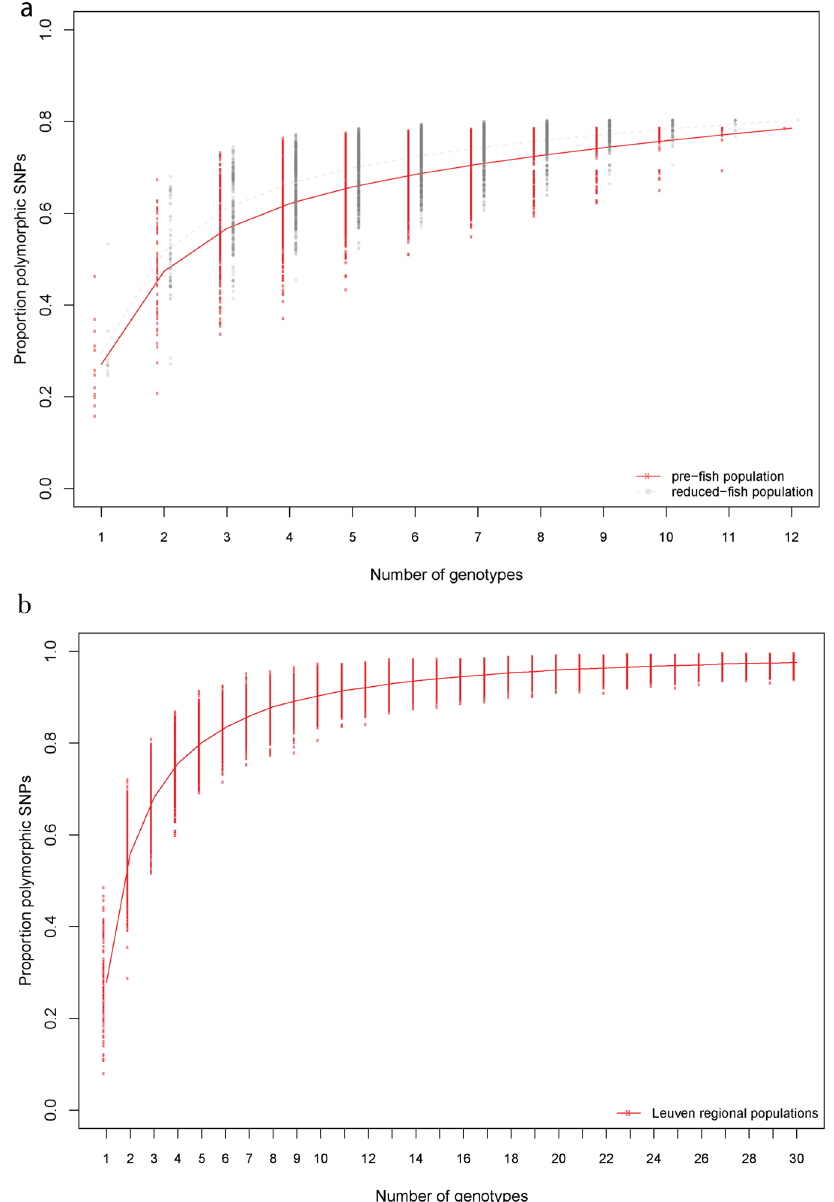
Fig. 4 Rarefaction curves for the proportion of polymorphic SNPs. a The proportion of SNPs ( N = 1109) that were potentially under positive selection (i.e., excluding hitchhiked loci) in the OHZ population that is polymorphic as a function of random samples of an increasing number of individuals from the pre- fi sh (solid, thick red line) and reduced- fi sh (hatched, thinner gray line) temporal subpopulations. The lines show that the amount of polymorphisms captured by even a low number of individuals is high in both populations, and that prior exposure to selection results in an even higher amount of polymorphism in the reduced- fi sh compared with the pre- fi sh population. b The proportion of SNPs that were potentially under positive selection (i.e., excluding hitchhiked loci) in the OHZ population that were also found in the spatial dataset ( N = 1003; i.e., 90.4% of the SNPs from Fig. 4a) that is polymorphic as a function of an increasing number of individual genotypes from the nine Leuven regional populations (i.e., the populations in the immediate neighborhood of OHZ) (solid, thick red